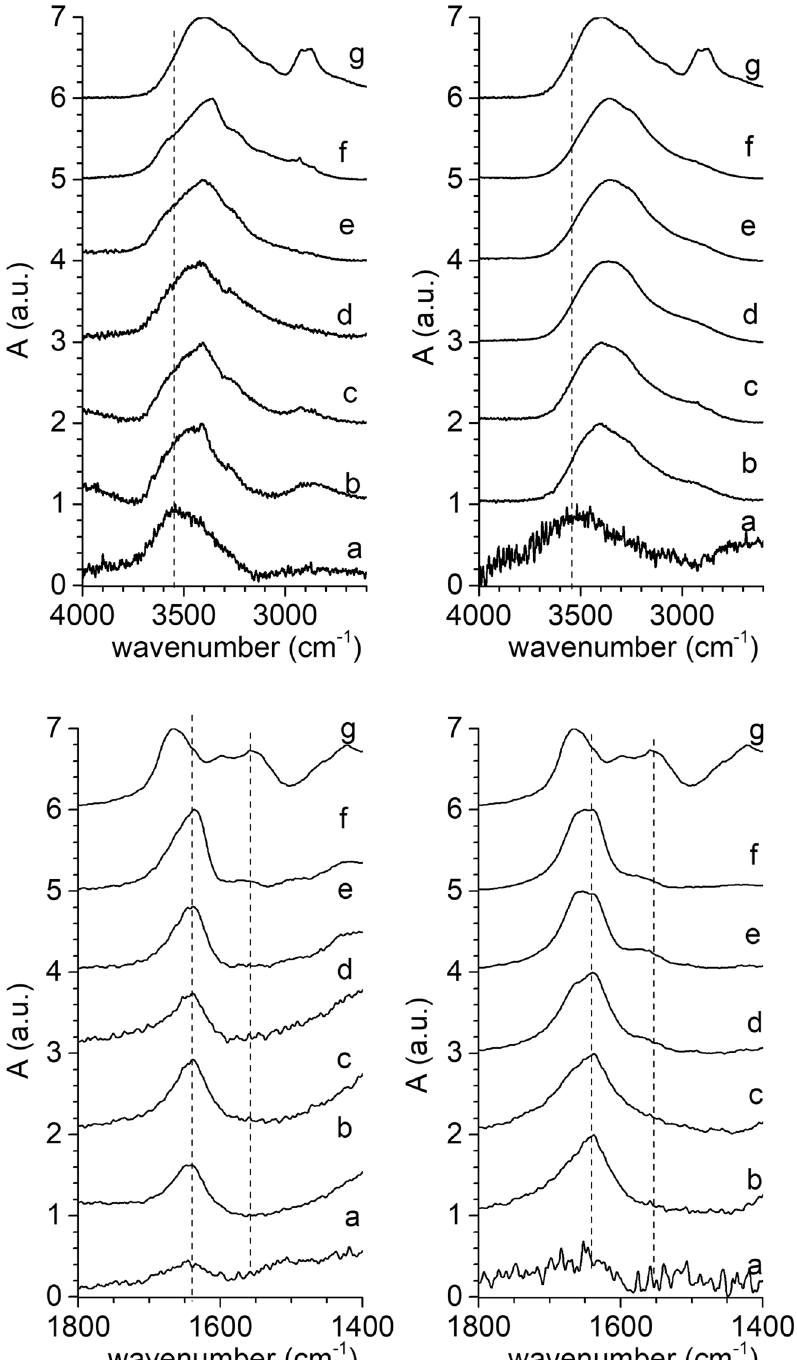
Figure 2. 4000–2600 cm − 1 and 1800–1400 cm − 1 regions of the FTIR spectra of Mica-2 ( n = 2), left graph, and, Mica-4 ( n = 4), right graph. ( a ) NaM n , ( b ) Ch-NaM n -A, ( c ) Ch-NaMn-B, ( d ) Ch-NaM n -C, ( e ) Ch-NaM n -D, ( f ) Ch-NaM n -E, and, ( g )